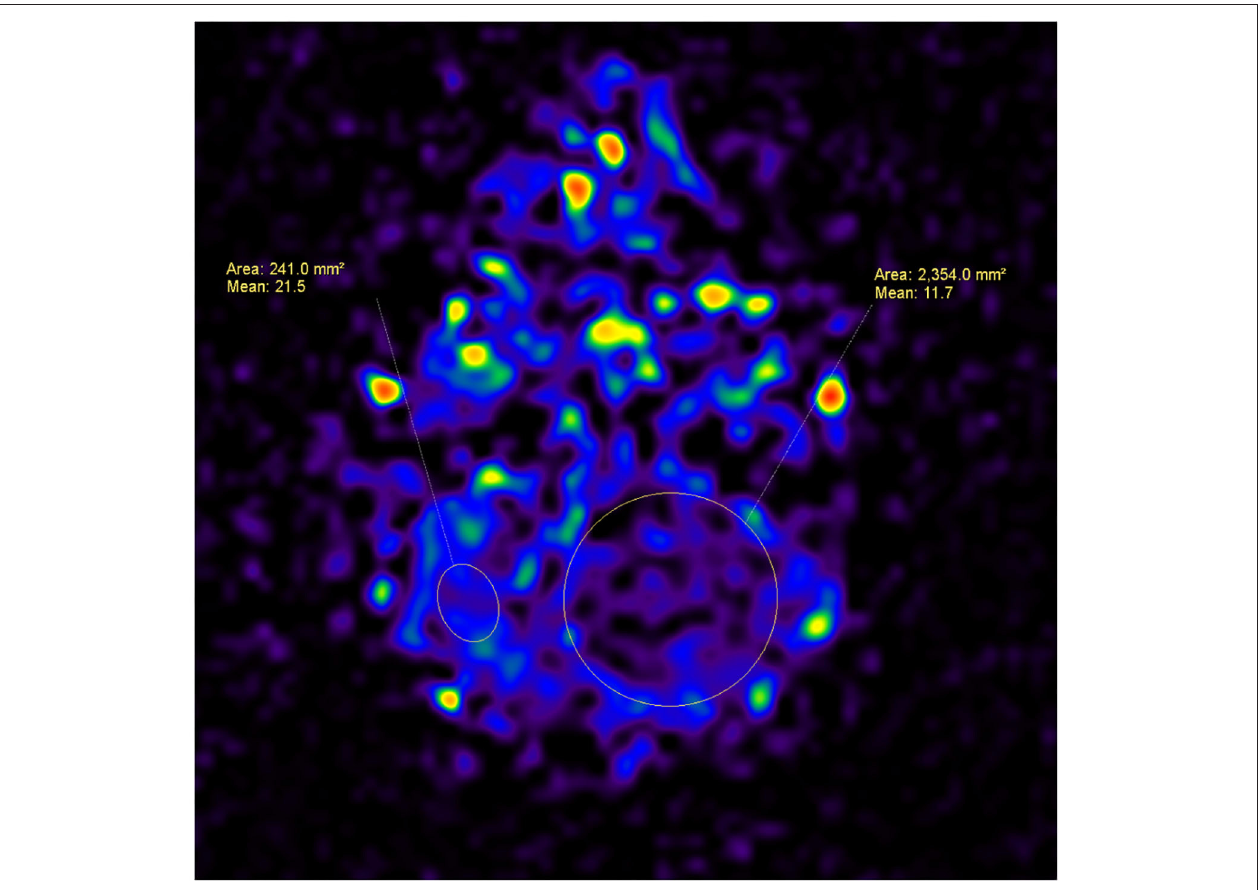
FIGURE 2 | A 4-year-old male patient, with a tumor in the left cerebellar hemisphere, which was confirmed as pilocytic astrocytoma after surgery. An ASL map was analyzed by drawing ROIs within the area of the tumor and the area of the parenchyma. The CBF for the pilocytic astrocytoma is lower than that for the parenchyma (11.7 vs. 21.5).